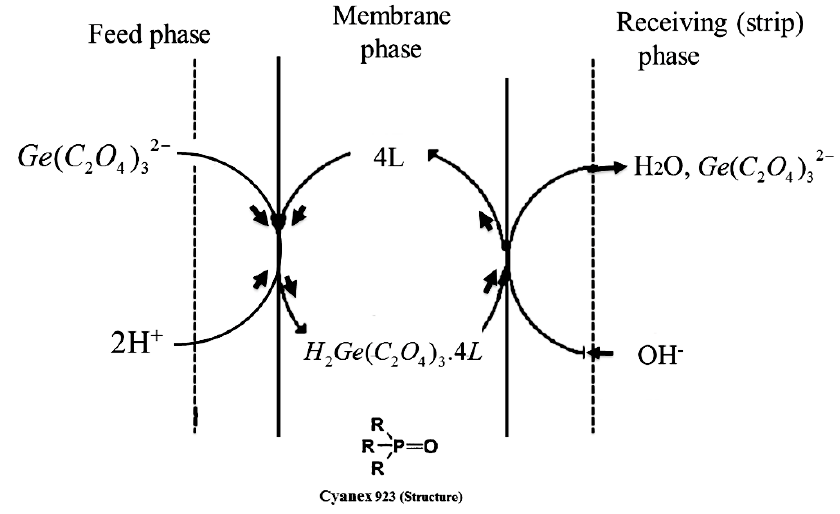
Figure 7. A schematic transport of germanium ion through FSSLM-Cyanex923.